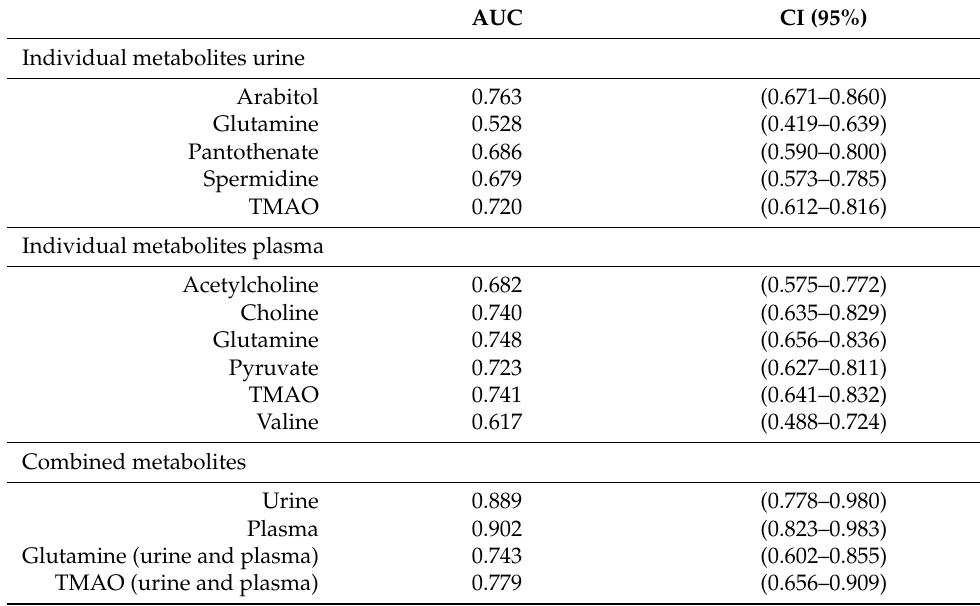
Table 2. Metabolites potential as biomarkers of cardiovascular risk, evaluated by ROC curves calculation. AUC: area under the curve. CI: confidence interval.